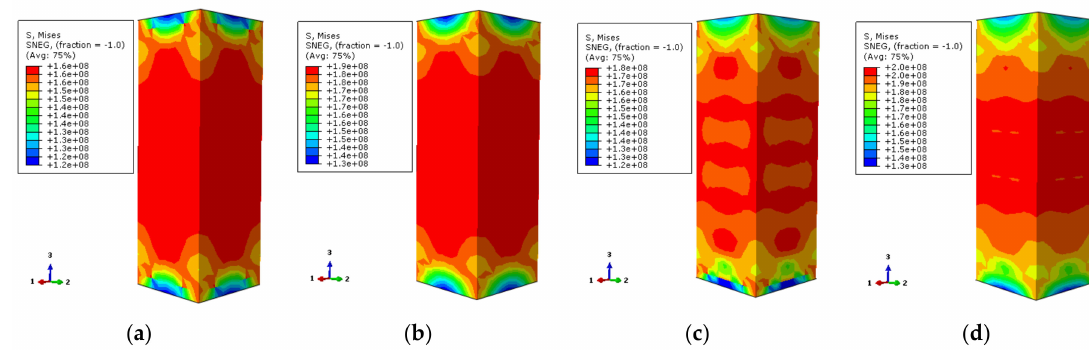
Figure 19. The Mises stress distribution of the steel tube ( a ) DS-600-0-0.75 ( b ) DS-600-0-1 ( c ) DS-600-0.75 ( d )